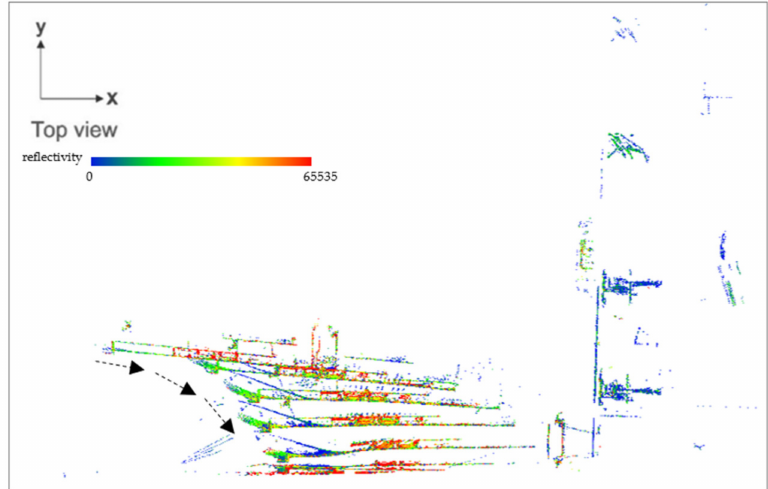
Figure 9. Ship berthing